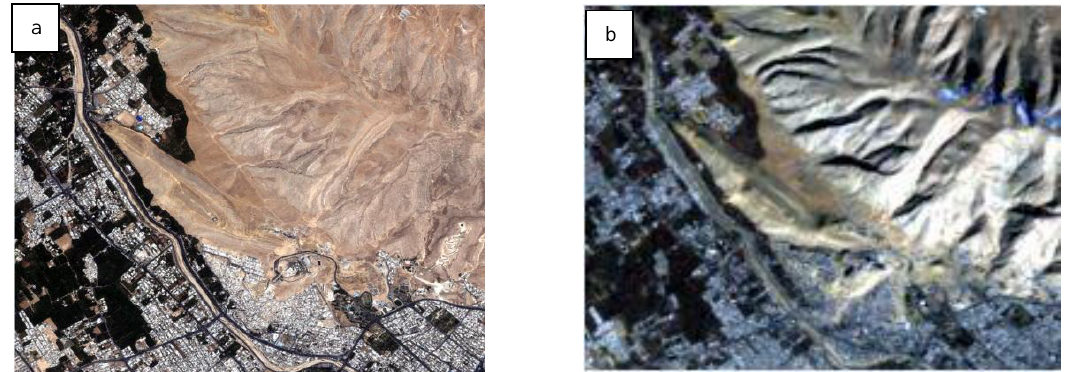
Figure 1. Images. (a) Ikonos image (R/G/B)=(1/2/3); (b) Landsat image